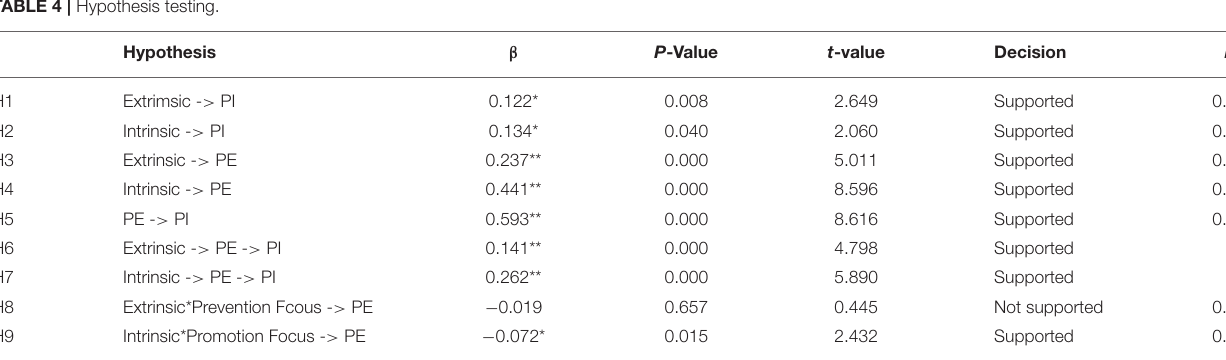
TABLE 4 | Hypothesis